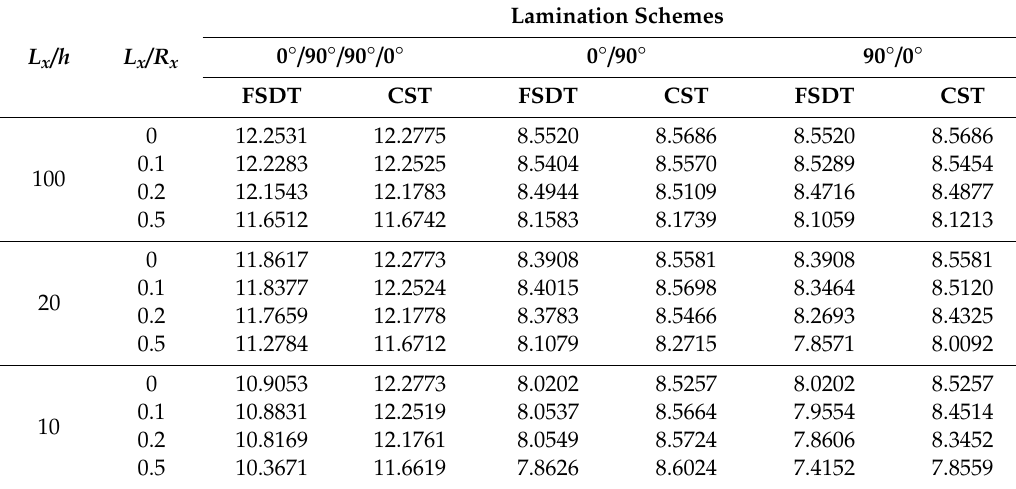
Table 9. The fundamental frequency parameter Ω for three types of layered composite shallow hyperbolic paraboloidal shells for variety theories, length to thickness ratios L x / h , and length to radius ratios L x / R x with the SD-SD boundary